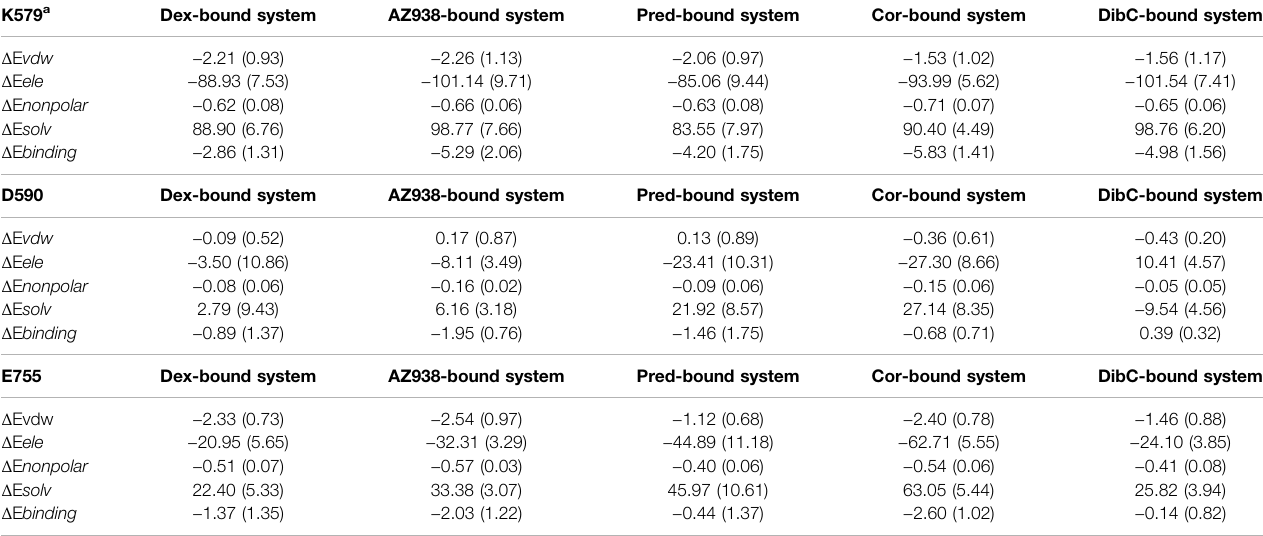
TABLE 1 | Free energy analysis (kcal/mol) for K579, D590, and